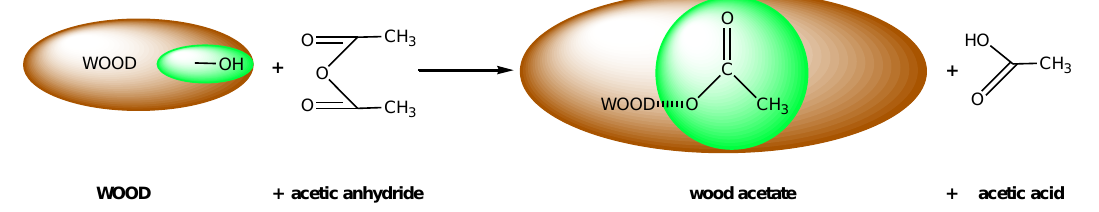
Figure 1. The reaction of wood with acetic anhydride.